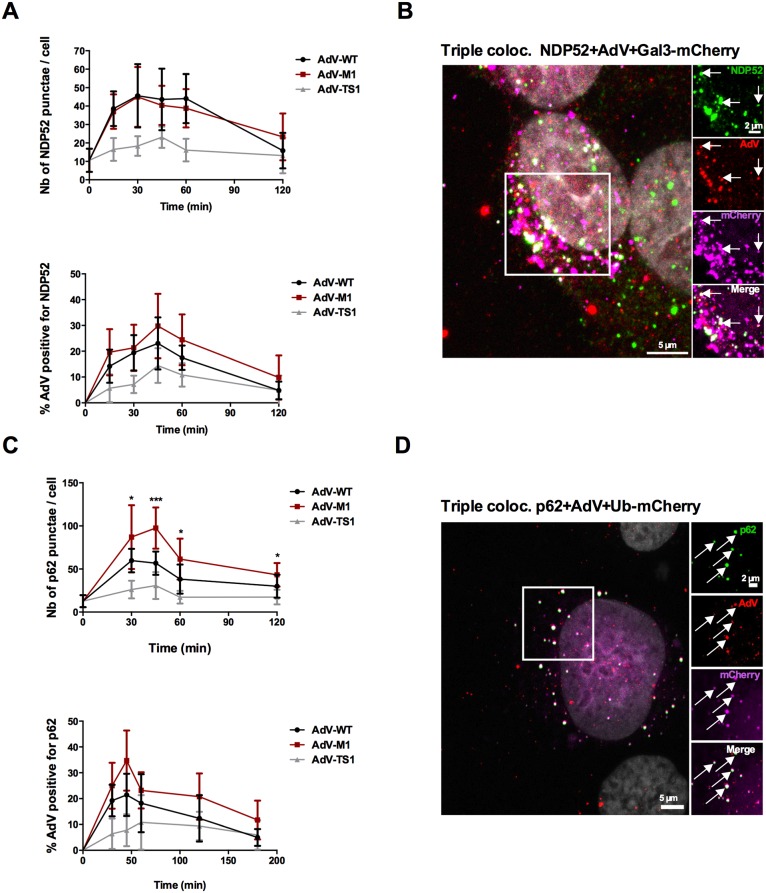
Recruitment of adaptor proteins NDP52 and p62 upon entry.(A) U2OS cells were infected with WT (black line), M1 (red line) or TS1 viruses (gray line) as outlined in Fig 3A. At each time points cells were fixed and stained for NDP52. The top panel shows the absolute number of NDP52 punctae per cell, the bottom panel the percentage of NDP52 positive particles. Error bars show cell-to-cell variations (n>10 cells; NS: no significant; *: P<0.05; **: P<0.01; ***: P<0.005 and errors bars are standard deviation). (B) U2OS cells stably expressing Gal3-mCherry (depicted as magenta signal) were infected with WT viruses and fixed at 30min post infection and stained with anti-AdV (red signal) and anti-NDP52 (green signal). The insets to the right show triple colocalization (AdV+Gal3mCh+NDP52) indicated by arrows (white signal). (C) U2OS cells were infected as in (A) and stained for p62. The top panel shows is the absolute number of p62 punctae per cell, the bottom panel the percentage of p62 positive particles. (D) U2OS cells transfected with a plasmid encoding Ubiquitin-mCherry (depicted as magenta signal) were infected with WT viruses and fixed at 30min post infection and stained with anti-AdV (red signal) and anti-p62 (green signal). The insets to the right show triple colocalization (AdV+UbmCh+p62) indicated by arrows (white signal).